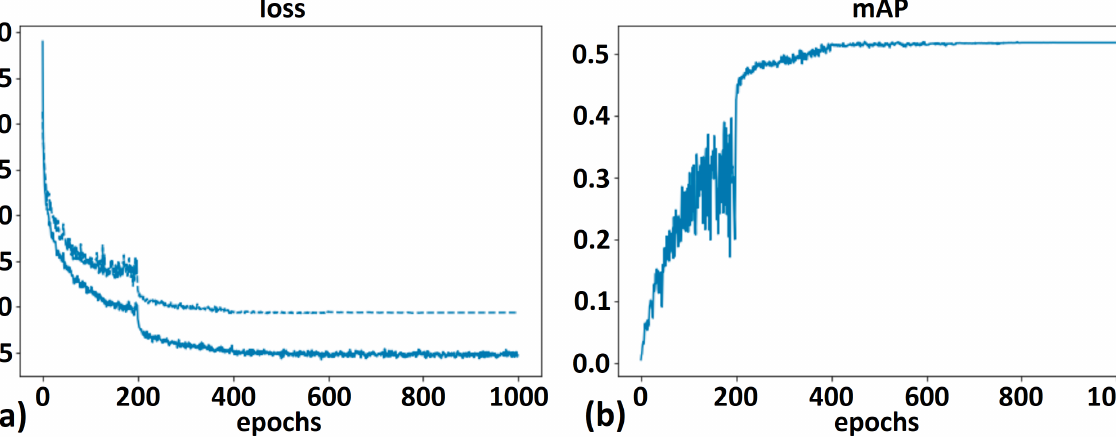
Figure 6. DETR results: ( a ) loss function obtained for the training set (solid line) and the validation set (dashed line) during 1000 epochs, for all categories (3rd experiment); ( b ) mAP scores obtained for the validation